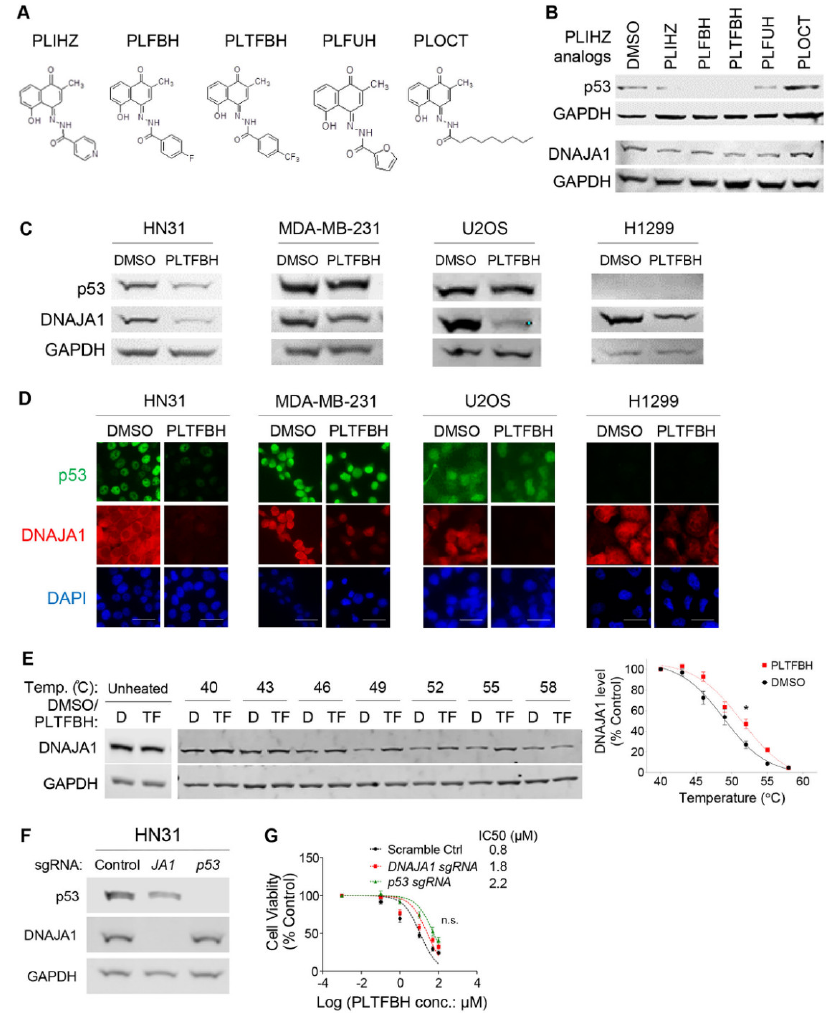
Figure 3. PLTFBH, an analog of PLIHZ, specifically reduces conformational mutp53 levels similar to PLIHZ. ( A ) Chemical structures of PLIHZ analogs including PLIHZ, PLFBH, PLTFBH, PLFUH, and PLOCT. ( B ) Western blotting for p53 and GAPDH using HN31 cells treated with different PLIHZ analogs (40 μM for 24 h). ( C ) Western blotting for p53, DNAJA1, and GAPDH using HN31, MDA-MB-231, and U2OS cells treated with PLTFBH at ~1/2 of 24h-IC 50 . ( D ) Immunofluorescence for p53, DNAJA1, and DAPI using HN31, MDA-MB-231, U2OS, and H1299 cells treated with PLTFBH at ~1/2 of 24h-IC 50 . Scale bar: 50 μm. ( E ) CETSA showing intracellular binding of PLTFBH to DNAJA1 in CAL33 cells: a representative Western blotting for DNAJA1 and GAPDH using protein extracts from HN31 cells ( left ); a summarized graph showing normalized DNAJA1 band densities at different temperatures ( right ). Mean ± SEM from three independent experiments ( n = 3). * p < 0.05 for two-way ANOVA. ( F ) Western blotting for p53, DNAJA1, and GAPDH using HN31 cells with or without knockout for DNAJA1 ( JA1 ) or p53 ( p53 ) using the CRISPR-Cas9 strategy. ( G ) Summary of MTT assays using control, DNAJA1 knockout, or p53 knockout HN31 treated with different concentrations of PLTFBH for 72 h. Mean ± SEM from three independent experiments ( n = 3). n.s.: not significant for one-way ANOVA. IC 50 values of PLTFBH for each sub-cell line are shown on the right.